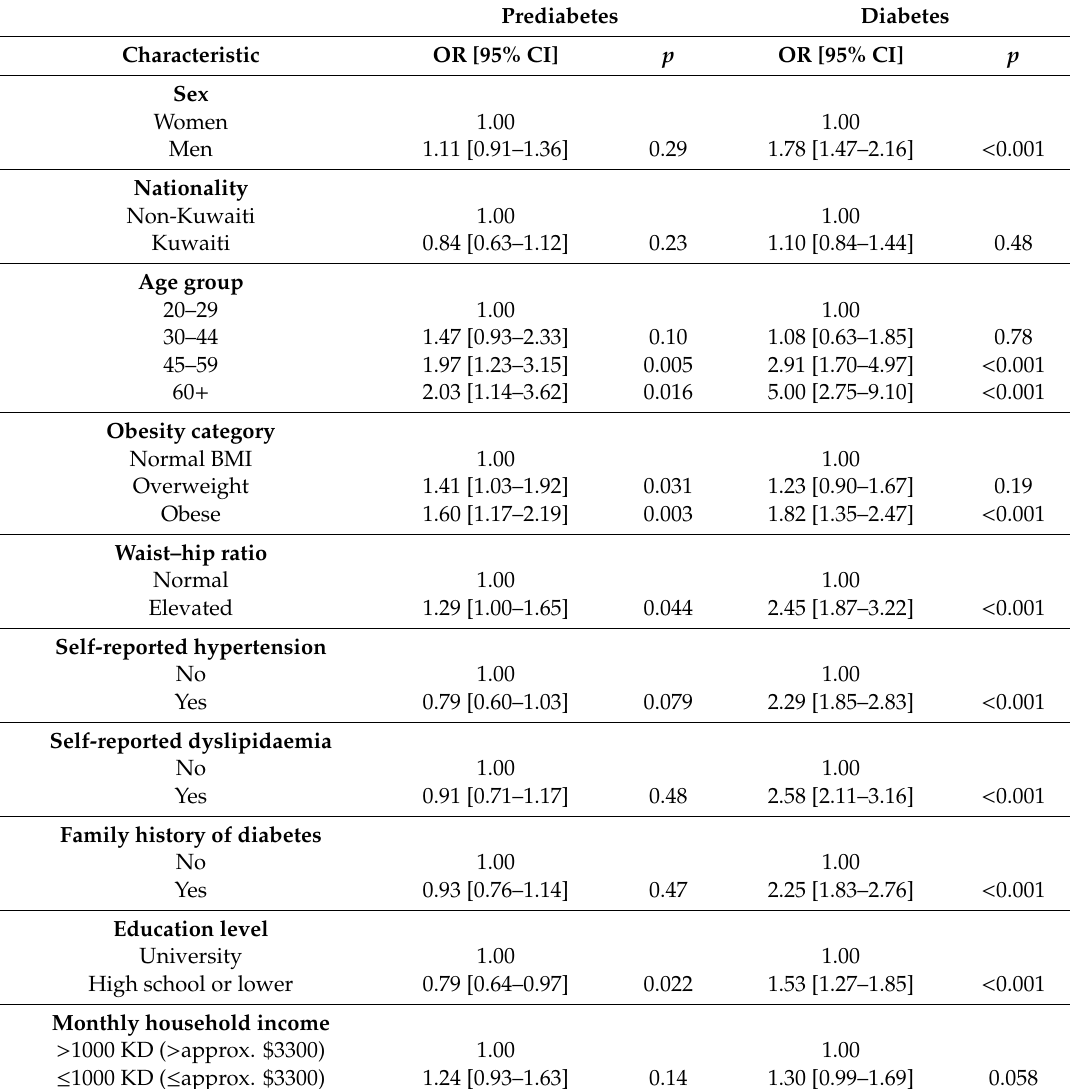
Table 4. Factors associated with prediabetes and diabetes in adults aged 20 years or more.